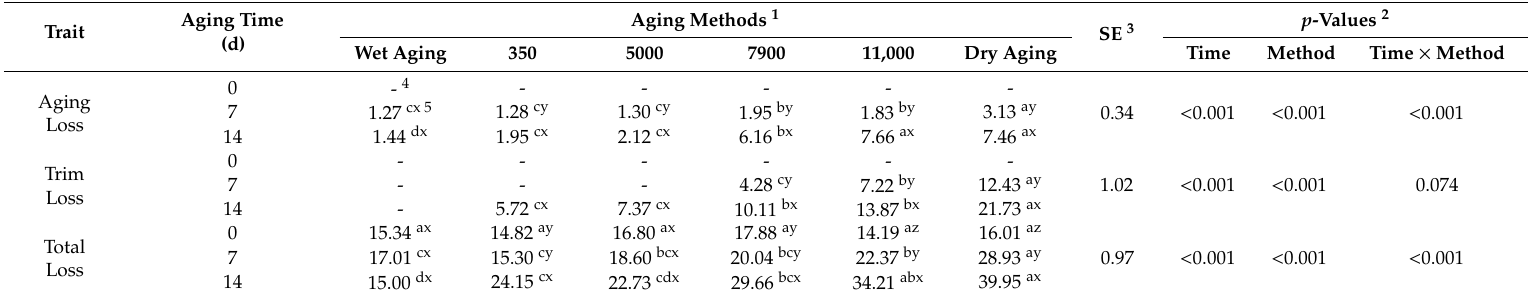
Table 1. E ff ects of di ff erent aging methods and aging time on the weight loss (%).